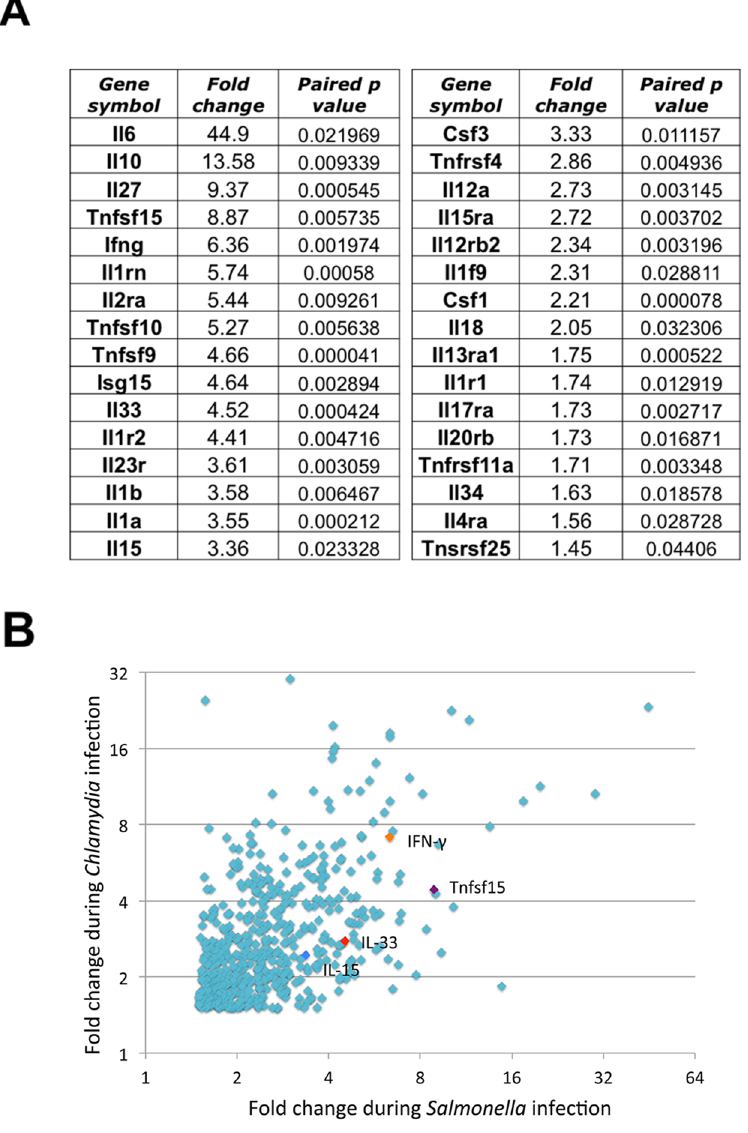
Fig 2. LPS induces a varietyof cytokines in infected mice. C57BL/6mice were infected intravenously (i.v.) with 5 × 10 5 Salmonella Typhimurium or 1x10 7 Chlamydiamuridarum . Two weeks (Salmonella) or one week (Chlamydia) later, infected mice were injectedi.v. with 10 μ gLPS or untreated,before spleens were collected4 hours later, and snap frozen prior to total RNA extraction for microarray analysisusing the Affymetrix GeneChipMouse Gene 1.0 ST Array. Data were analyzedin dchip to provide mean gene expressionvalues and fold-change comparisons betweenLPS-treated and untreated group means for each infection. (A) A select list of genes of interest for which RNA expressionwas upregulatedin the spleenof Salmonella -infectedmice 4 hours after LPS stimulation.Means were comparedby pairedt-test to generate the indicatedp values. (B) Scatter plot shows the upregulation of genes that occur in both Salmonella -infected (x-axis) and Chlamydia -infected (y-axis) mice after LPS stimulation,with genesof particularinterest highlighted.Microarray results were filtered to includeonly genesupregulatedat least 1.5-fold, with p values greater than 0.05, for both datasets. Data were generatedfrom 3 mice per experimental group. Data analyses,statistics, and filtering were performed in dchip, comparisonof datasets, sorting, and scatterplot used Microsoft